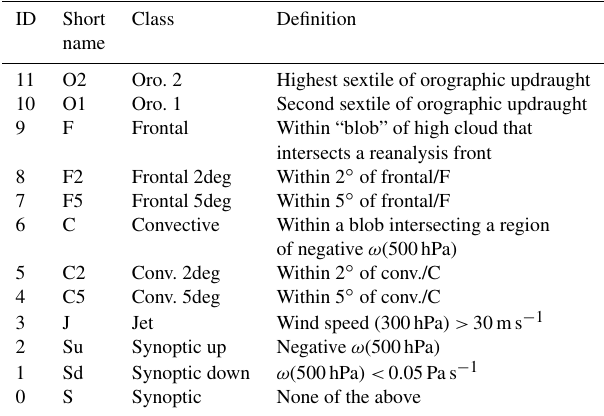
Table 1. Classification criteria. Grid boxes are assigned the highest applicable class, regardless of if a cloud is